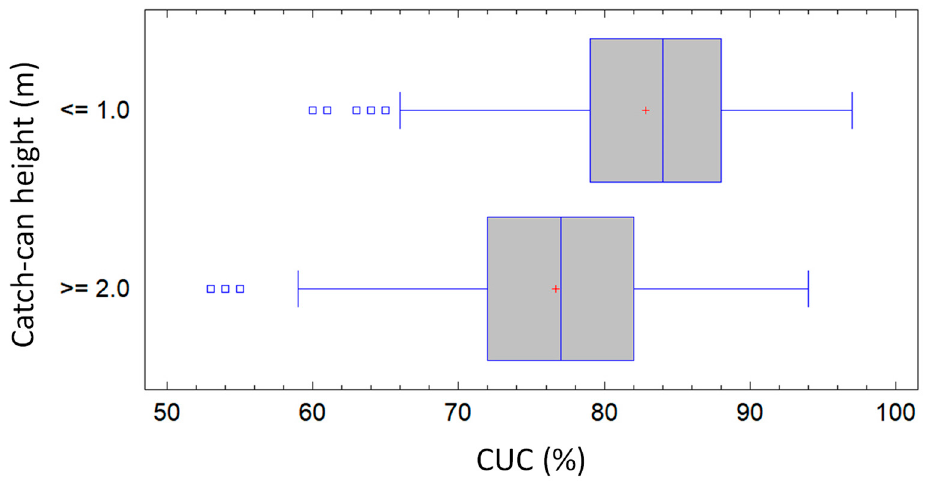
Figure 11. Box and whisker plot for CUC observed related to the catch can height for the 396 experiments showed Figure 10.